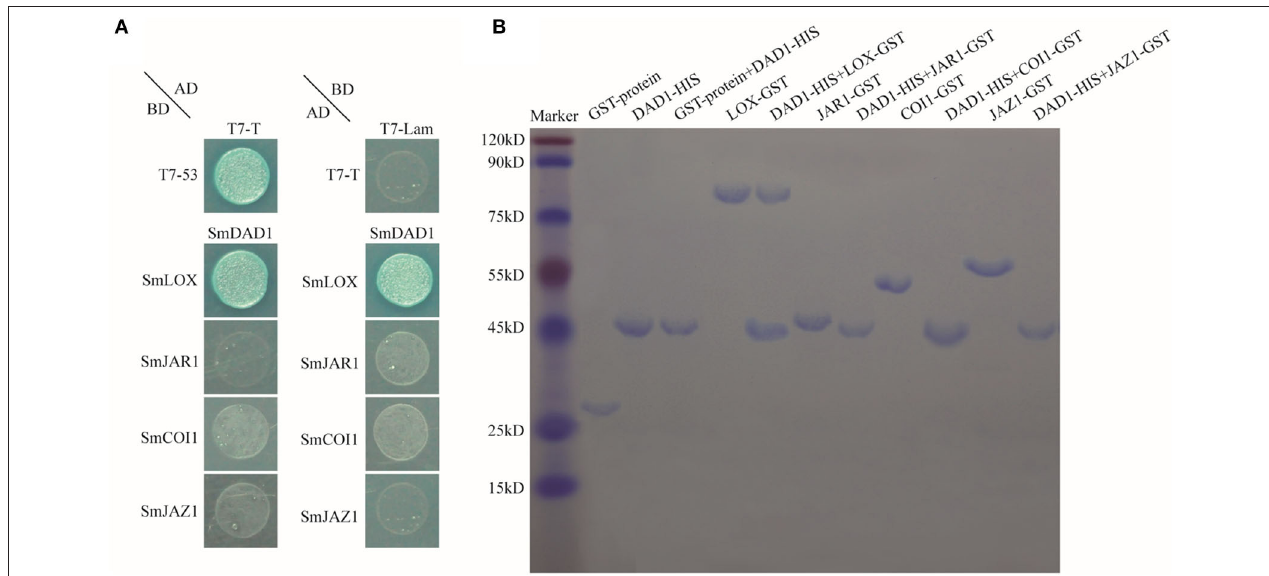
FIGURE 7 | Protein interactions of SmDAD1 with SmLOX, SmJAR1, SmCOI1, and SmJAZ1. (A) Detecting interactions of SmDADA1 with SmLOX, SmJAR1, SmCOI1, and SmJAZ1 by yeast two-hybrid assay. Transformed yeast cells were plated on SD/-Ade/-His/-Leu/-Trp/X-a-Gal medium to grow at 30 ◦ C for 3–5 days. pGBKT7-T53 (T7-T53) combined with pGADT7-T (T7-T) was used as positive controls, and pGBKT7-lam (T7-lam) combined with pGADT7-T (T7-T) was used as negative controls. (B) Examining the interactions of SmDAD1 with the other proteins by Pull-down. The HIS-tagged SmDAD1 protein was generated by cloning into the pET32a ( + ) vector (19 kDa). The GST-tagged proteins of SmLOX, SmJAR1, SmCOI1, and SmJAZ1 were generated by cloning into the pGEX-4T-1 vector (26 kDa). Bound proteins were eluted and stained with Coomassie Brilliant Blue 250 and then separated by 12.5%